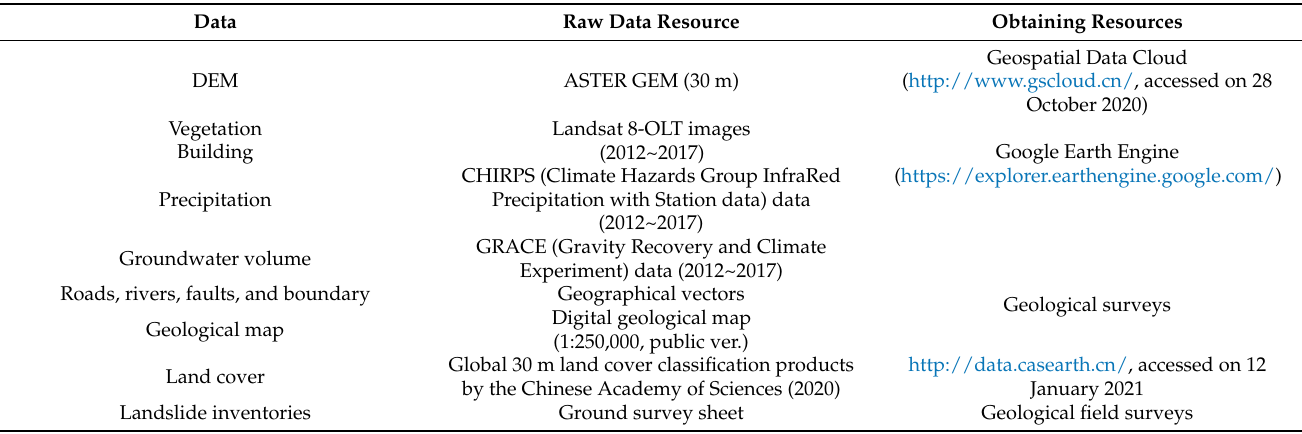
Table 1. Raw data resources for feature extractions and geohazard inventories, the obtaining re- sources (platforms or websites) are listed as well.